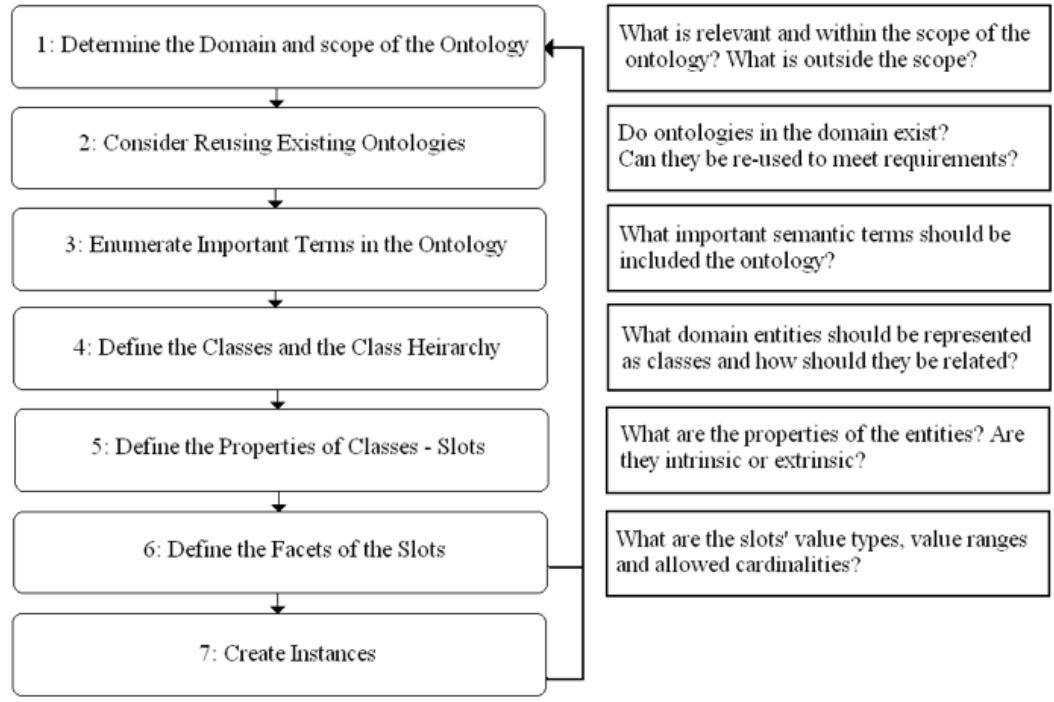
Figure 1. Steps in Ontology Development Process based on (Noy and McGuinness,